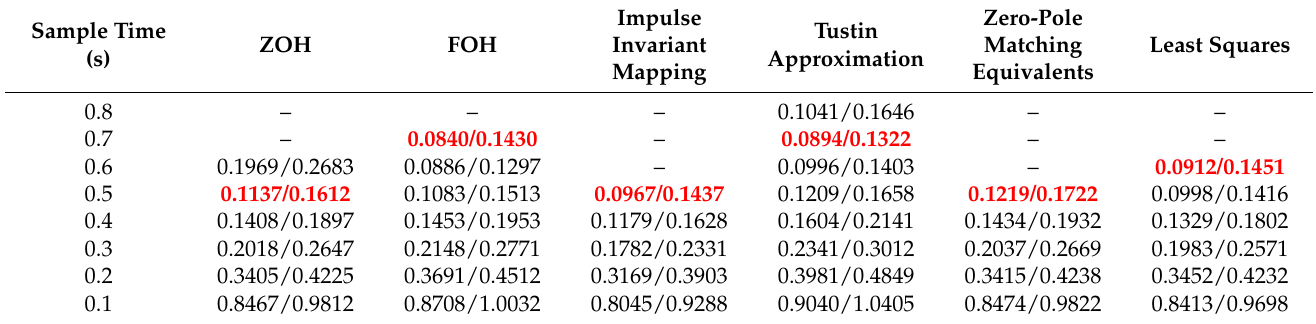
Figure 7. ( a ) Results presented in [16] for deterministic artificial intelligence tracking command trajectory. ( b ) Plots for the results obtained in most recent research [18], which shows that the performance of deterministic artificial intelligence is concerned with the efficacy of discretized implementations. Table 2. Mean and standard deviation of the error for various discretization methods and sample times. 1